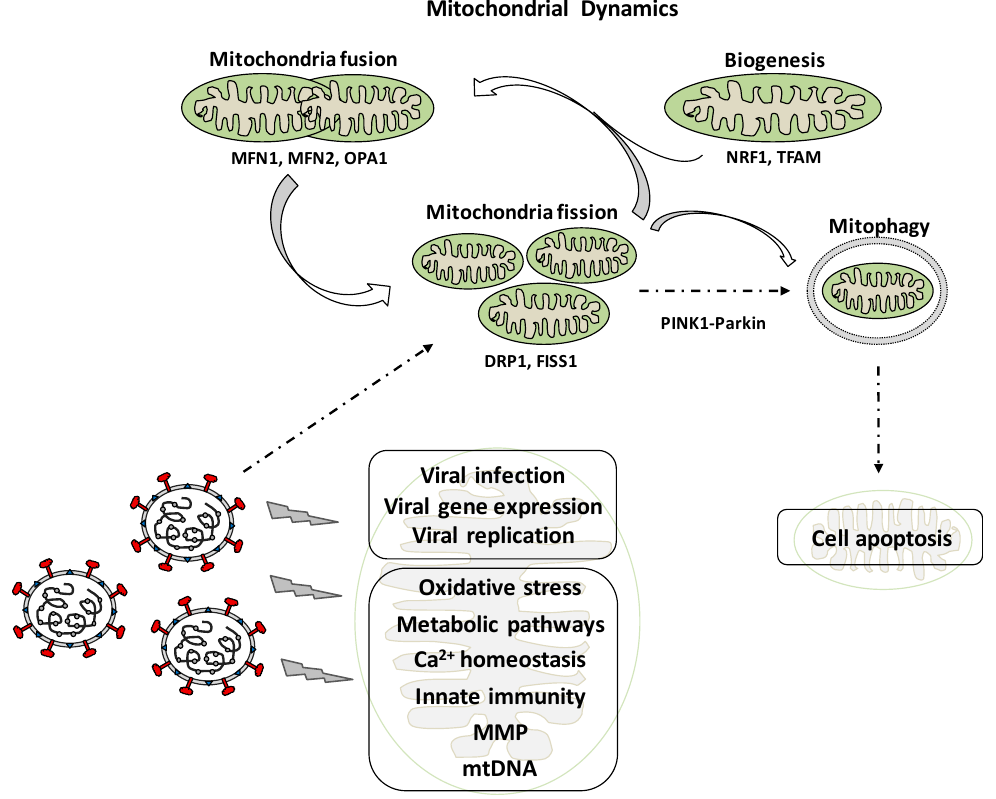
Figure 1. Effects of viral infection on mitochondrial dynamics, the viral life cycle, and various aspects associated with the internal metabolism of the mitochondria as well as its physiological processes.